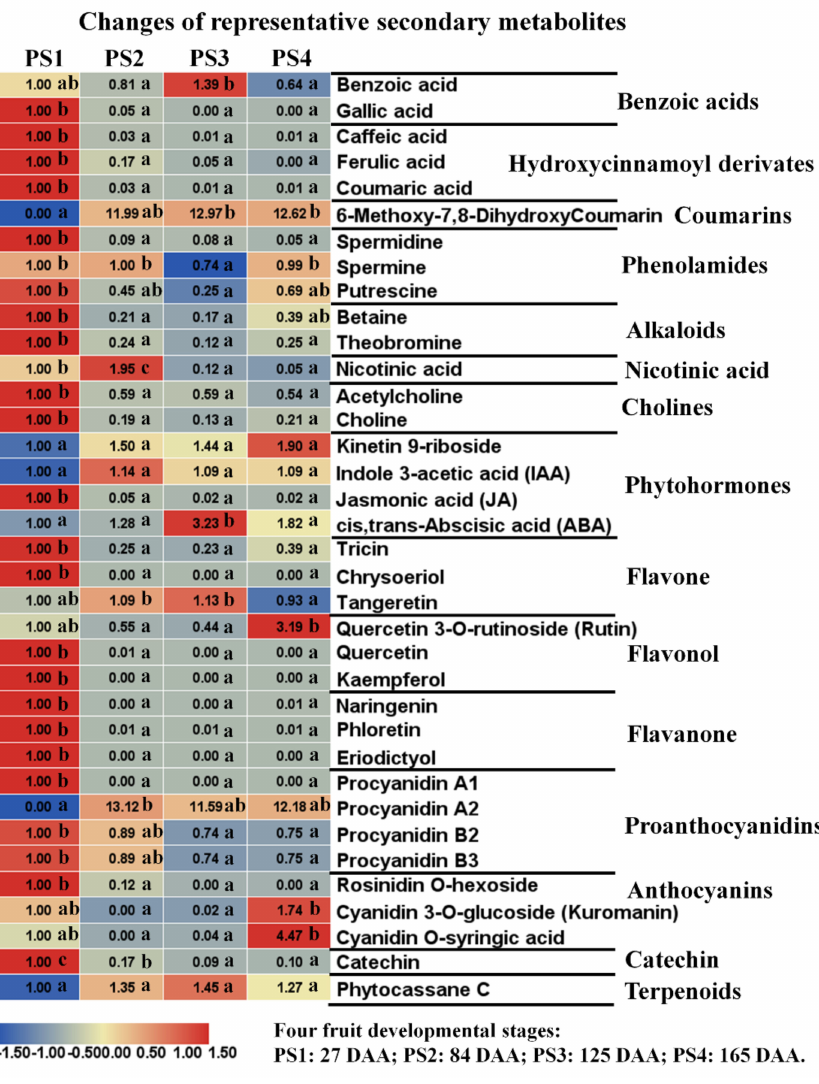
Figure 6. Representative secondary metabolites detected by widely-targeted UPLC-MC during four fruit developmental stages. The fold changes of each metabolite among these four stages were displayed in heat map which used the first stage of 27 Days After Anthesis (DAA) as the calibrator. PS1, 2, 3, and 4 represents four fruit developmental stages: 27, 84, 125, 165 Days After Anthesis (DAA), respectively. Three independent replicates were performed for each stage. Significant analysis was performed by SPSS software based on Tukey’s test at p < 0.05 level and showed with lower cases a, b, and c in figure. Di ff erent letters indicate significant di ff erences between two